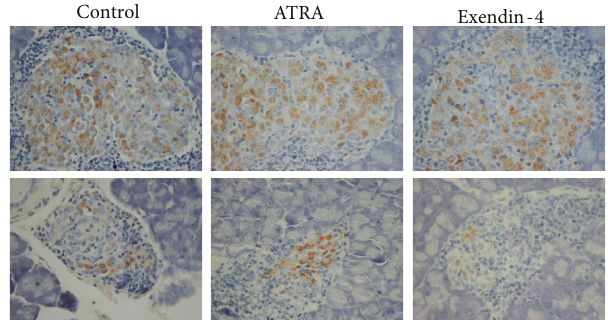
Figure 2: Varied degrees of insulitis with abundant (upper panel) to scanty (lower panel) beta cells were observed in the pancreases of adoptive transferred NOD/scid mice treated with vehicle, ATRA, and